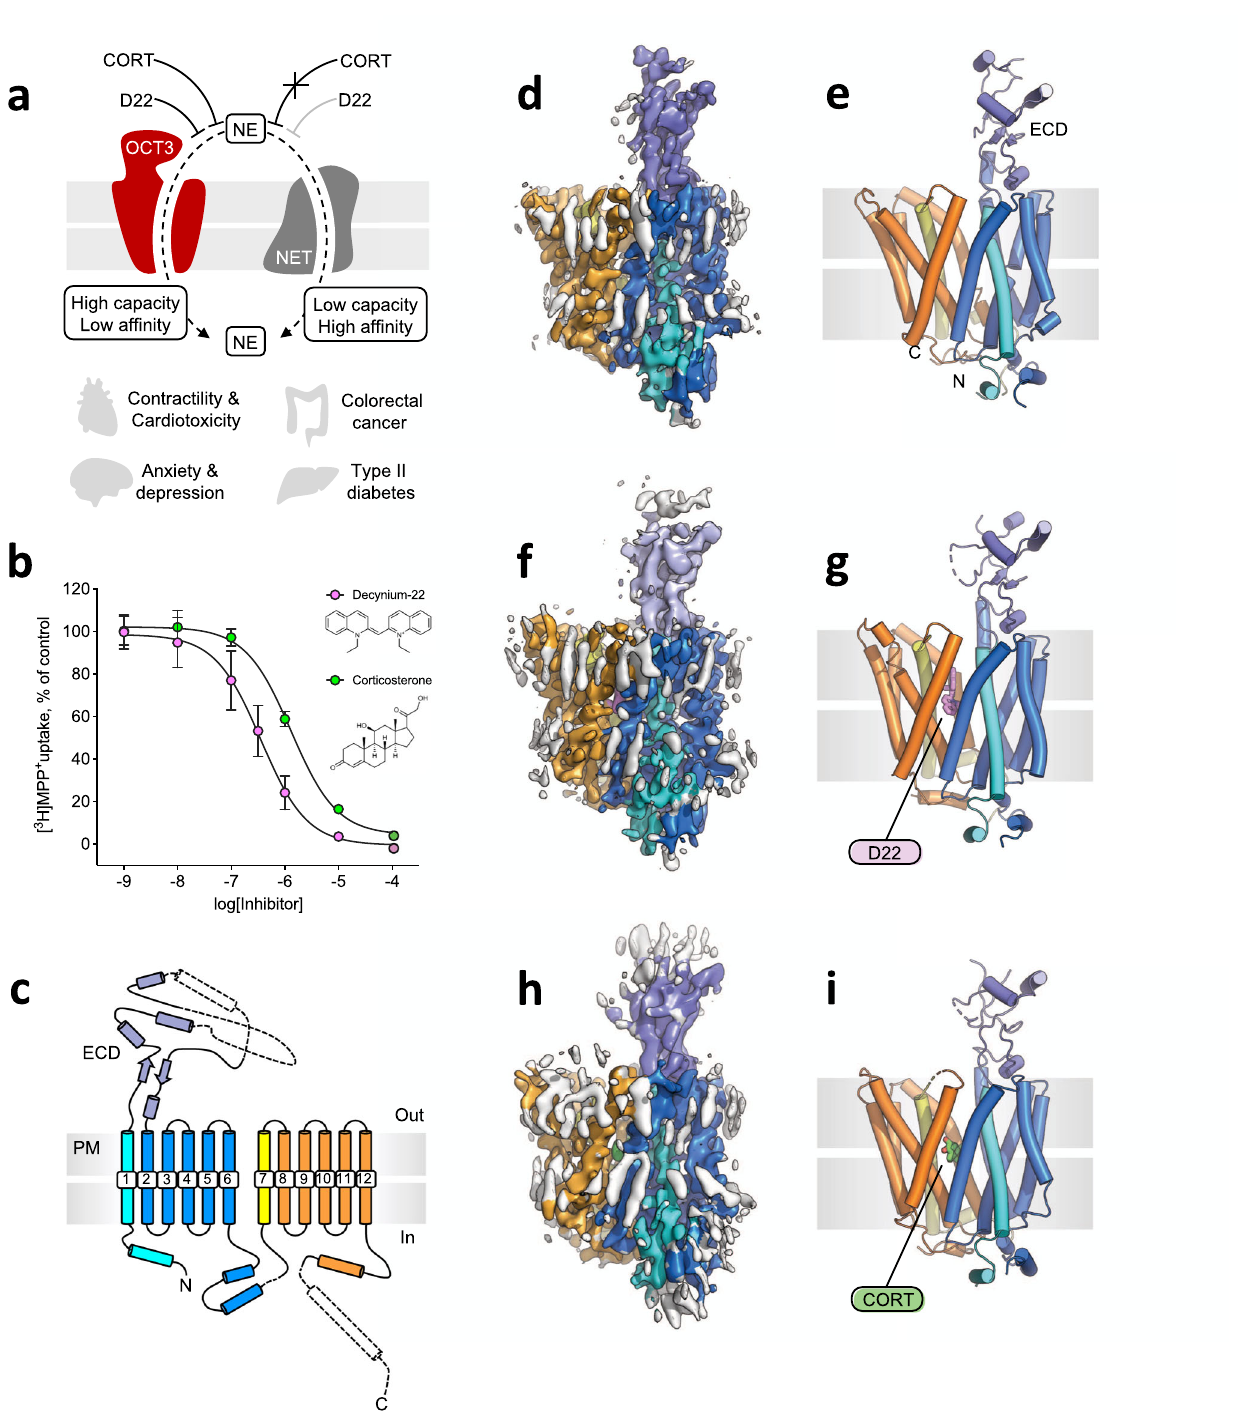
Fig. 1 | Structure and functionofOCT3.a Schematicrepresentation of OCT3;key features of the transporter are illustratedinthe panel. b OCT3 transportinhibition by decynium-22 (D22) and corticosterone (CORT). The values correspond to mean±SD; n =3 represents three biologically independent experiments that are conductedwiththreetechnicalrepeats. c Aschemedepictingthetopologyandthe secondary structure elements of OCT3. d , e The cryo-EM map ( d ) and model of